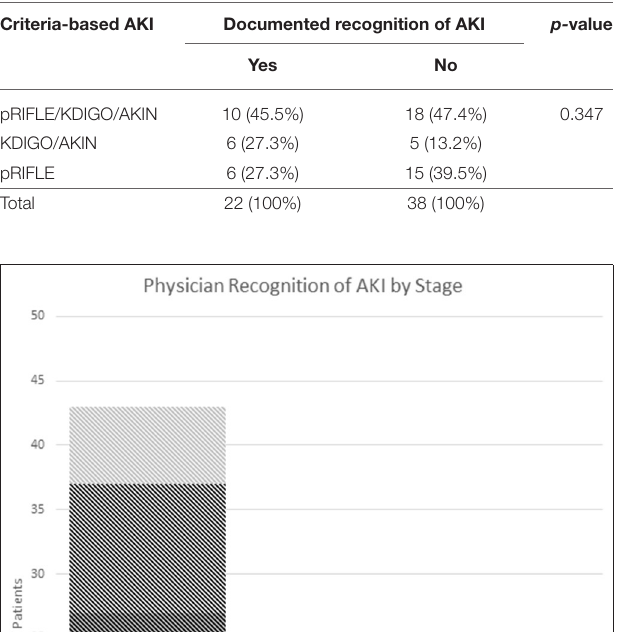
TABLE 3 | Comparison between AKI criteria and documented recognition of AKI.